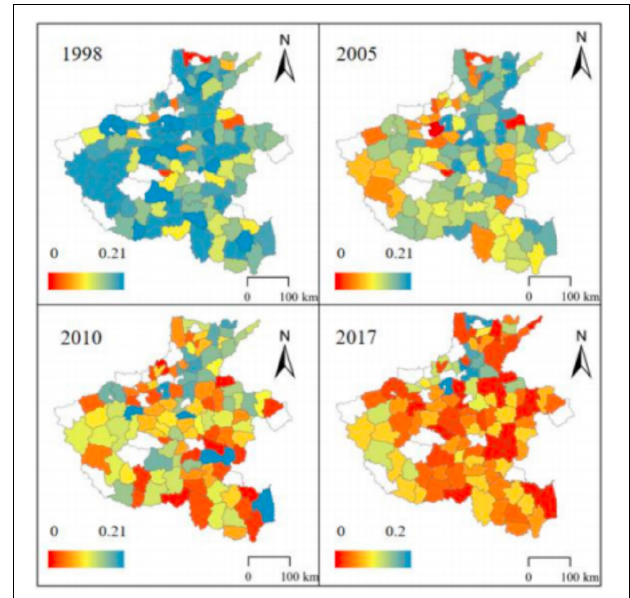
FIGURE 6 | Spatial difference of production function of cultivated land in Henan Province.